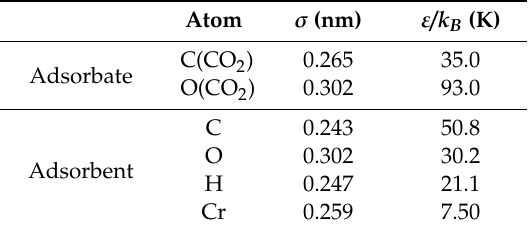
Table 3. Force field parameters.